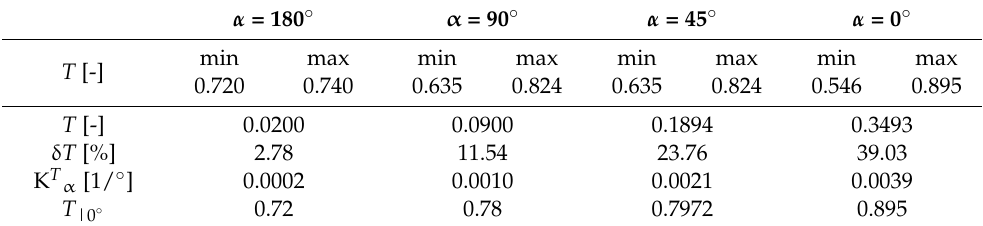
Table 1. Parameters of the produced TTFBG structures.